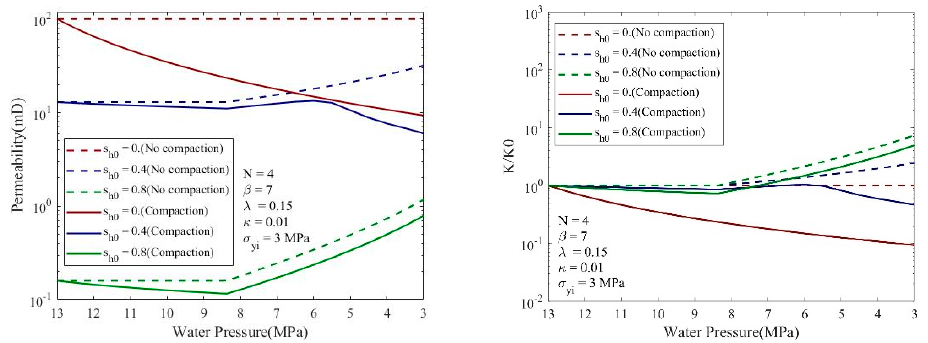
Figure 11. The vibration of effective permeability of HBSs with depressurization corresponding to different initial hydrate saturation (Left figures—permeability, Right figures—permeability ratio).